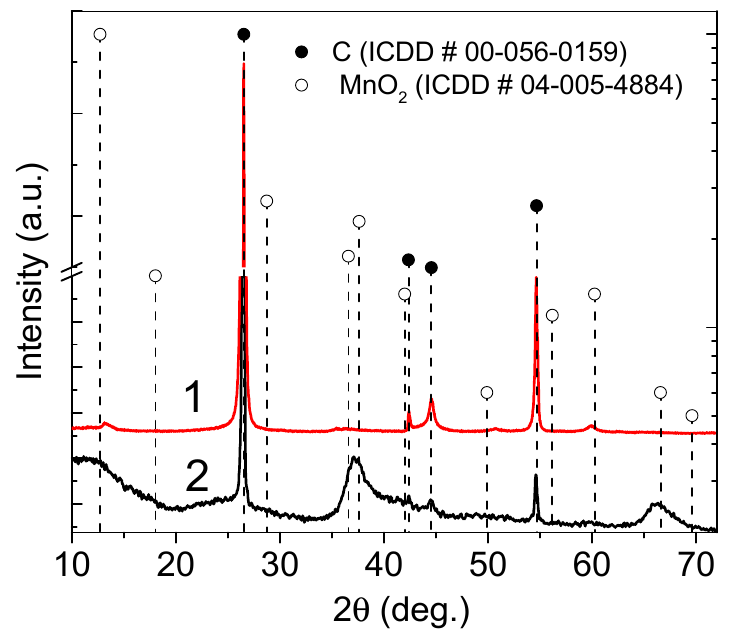
Figure 4. XRD patterns of samples S1 (1 pattern) and sample S2 (2 pattern). The electrochemical performance of samples S1 and S2 was evaluated from the cyclic voltammetry and galvanostatic charge/discharge measurements using a three-electrode system in a 1 M Na 2 SO 4 solution. Figure 5 shows the CV curves of the sample S1 (a), sample S2 (b), and pure carbon (c) at the scan rates of 10, 50, 100, and 200 mV s − 1 . No obvious peaks are observed in all the CV curves. This indicates that the electrodes are charged and discharge at a constant rate over the complete